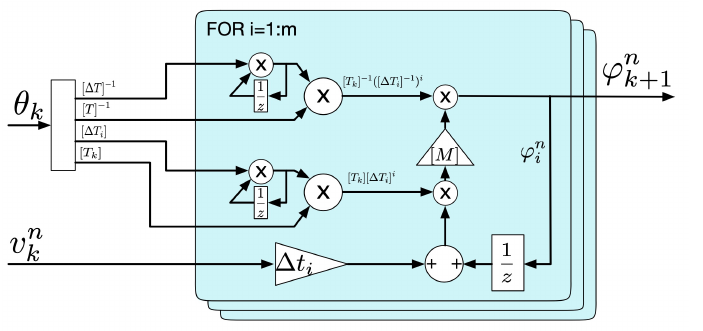
Figure 5. Discrete time model using the algorithm under study without optimization: